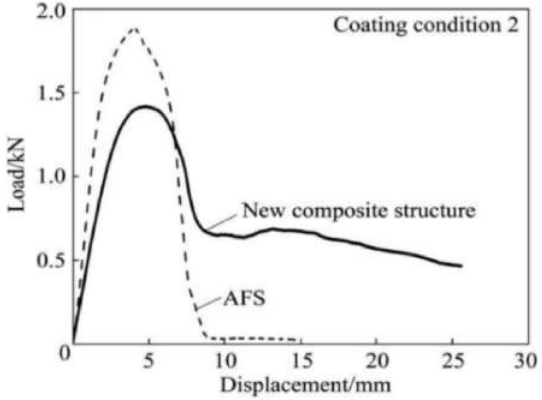
Figure 10. Load-displacement curves of new composite structure and AFS coated with epoxy resin [38] (Figure 10 is copied from other published papers, if original pictures were needed, please check the references.).